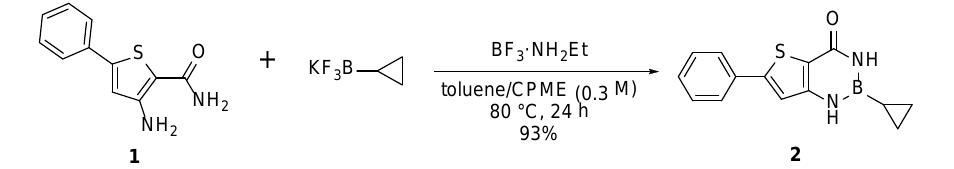
Figure 2. Examples of marketed boron-containing drugs.